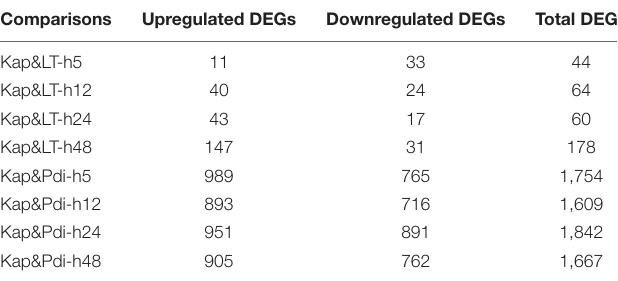
TABLE 2 | Number of differentially expressed genes of RNA-seq